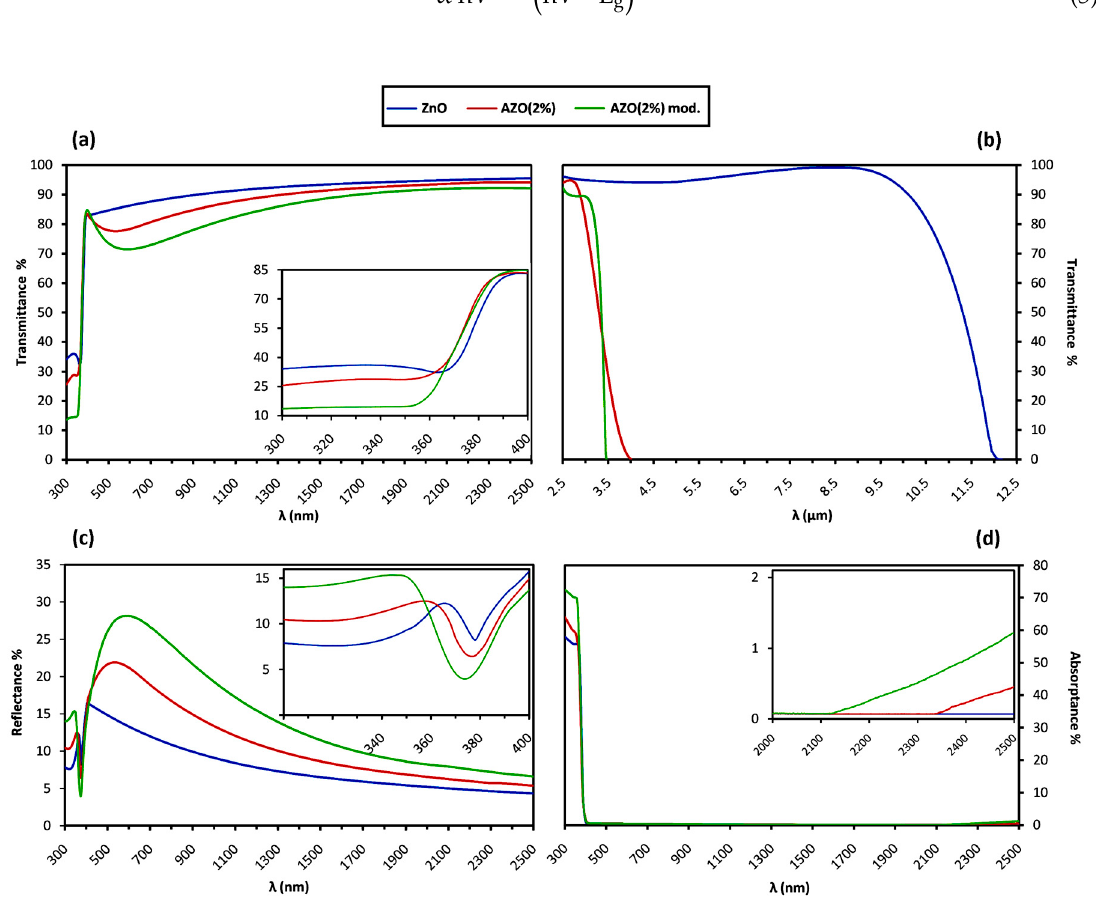
Figure 5. UV-Vis-NIR spectra of Group B samples: ( a ) transmittance, ( b ) extended transmittance, ( c ) reflectance, and ( d ) absorptance. Inset graphs for ( a ) and ( b ) show the magnification around the absorption edge, while for the absorptance spectra, the inset is the magnification of the far right range.